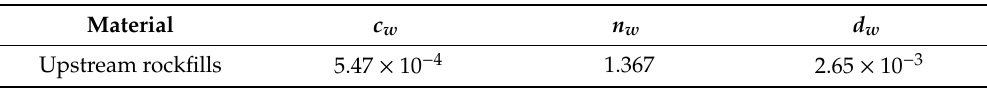
Table 4. Calibrated parameters of the wetting deformation model for the upstream